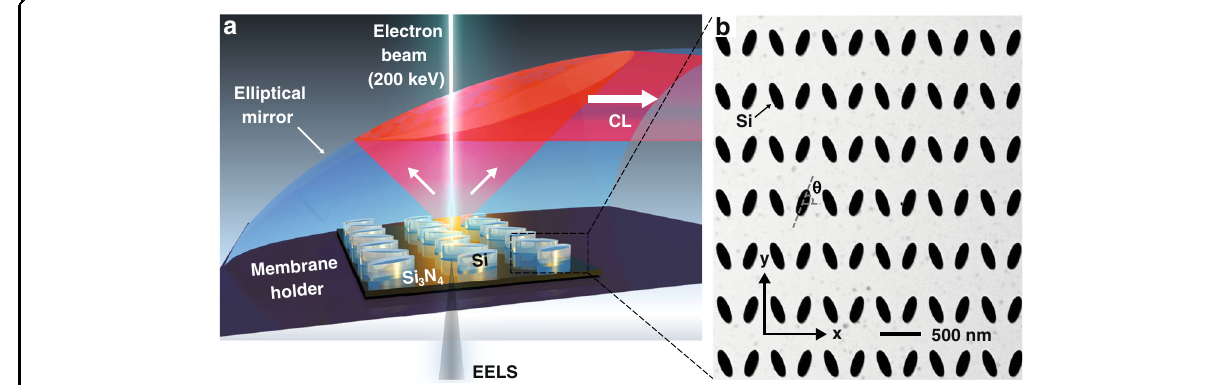
Fig. 1 Experimental setup for exciting and probing bound-states-in-the-continuum (BIC) modes via a sub-1-nm electron beam. a Schematic of the experimental setup in a STEM where a high-energy electron beam focused to ~1 nm is used to probe an array of Si nanoantennas on a 30-nm thick suspended Si 3 N 4 membrane. Complementary measurements of the energy lost by electrons, and energy of emitted photons result in EELS and CL spectra respectively. b Bright- fi eld STEM image of an amorphous Si nanoantenna array supporting quasi-BIC modes on a 30-nm-thick Si 3 N 4 membrane. “ True ” BIC occurs when θ ¼ 90